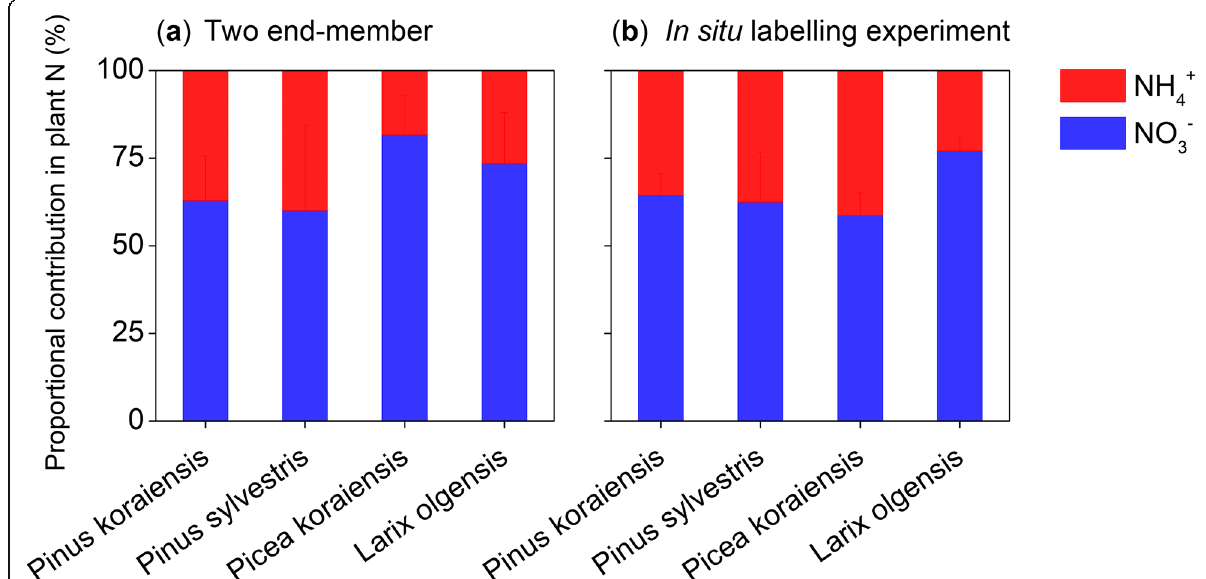
Fig. 4 Contribution of NH 4+ and NO 3 − to plant N uptake in the four forest plantations calculated by the two end-member ( a ) and from in situ labelling experiment in the previous study ( b ) (Zhou et al. 2020)